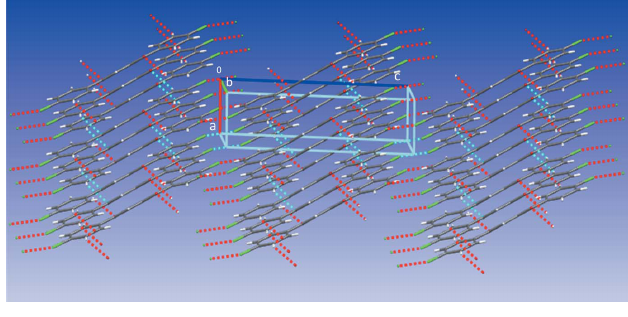
Figure 3 Crystal packing of ( 1 ) along the vicinity of the a axis. Dashed lines depict Cl1 (cid:3)(cid:3)(cid:3) Cl1 i and O1 (cid:3)(cid:3)(cid:3) H3 ii interactions [symmetry codes: (i) 2 (cid:4) x , (cid:4) y , (cid:4) z ; (ii) (cid:4) 1 + x , 1 + y , z